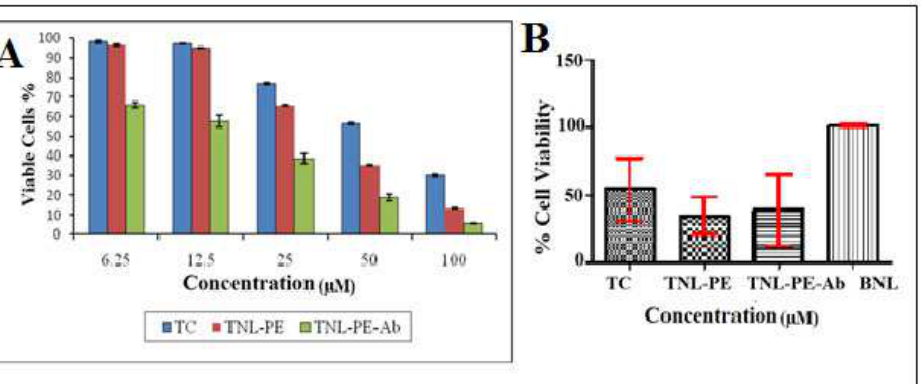
Figure 11. ( A ) Comparison of cell viability percentage between tamoxifen citrate loaded nanolipid vesicles with phosphoethanolamine (TNL-PE), antibody conjugated tamoxifen citrate loaded nanolipid vesicles (TNL-PE-Ab) and free drug solution (TC) on MCF-7 cells for 48 h. ( B )